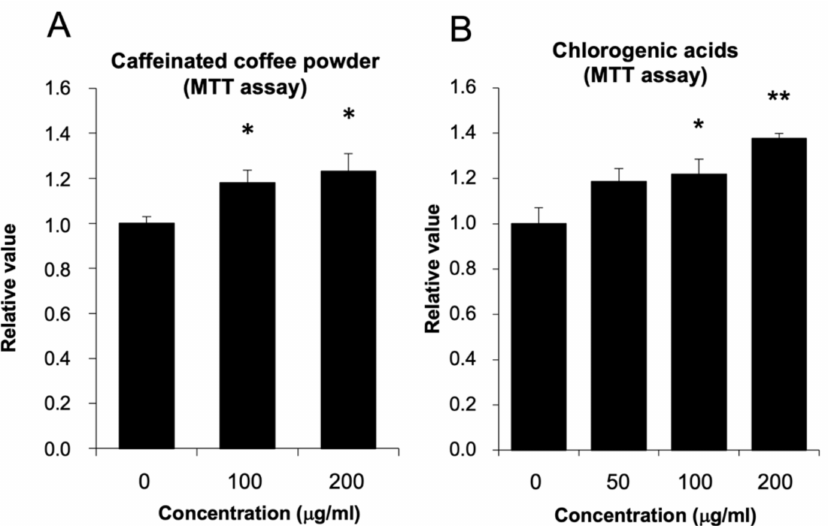
Figure 1. The effects of coffee powder and chlorogenic acid on hepatocellular carcinoma G2 (HepG2) cell viability. HepG2 cells were cultured in Dulbecco’s Modified Eagle’s Medium (DMEM) containing coffee powder or chlorogenic acid for 24 h. The results of the 3-[4,5-Dimethylthiazol-2-yl]-2,5- diphenyltetrazolium bromide (MTT) assay of cells cultured with ( A ) caffeinated coffee powder and ( B ) chlorogenic acid. The data are shown as mean ± SE ( n = 4). * p < 0.05, ** p < 0.01 vs. control group.